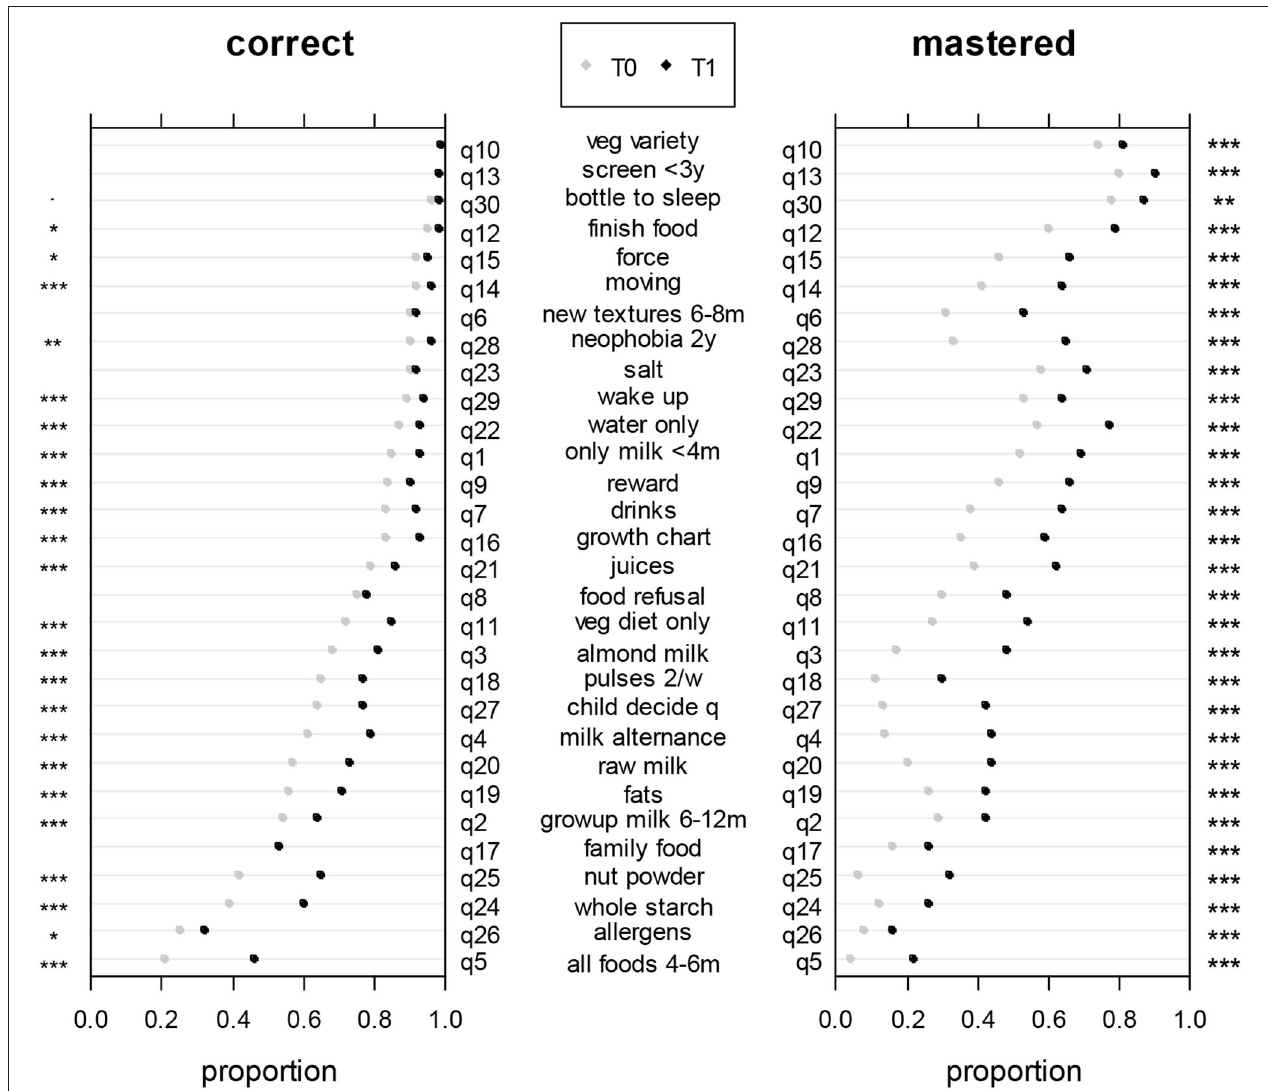
FIGURE 4 | Proportions of correct answers (on the left) and mastered answers (on the right) at T0 (gray dot) and T1 (black dot) for each question. The asterisks indicate whether the increase between T0 and T1 was significant (McNemar’s tests). * p < 0.05; ** p < 0.01; *** p <